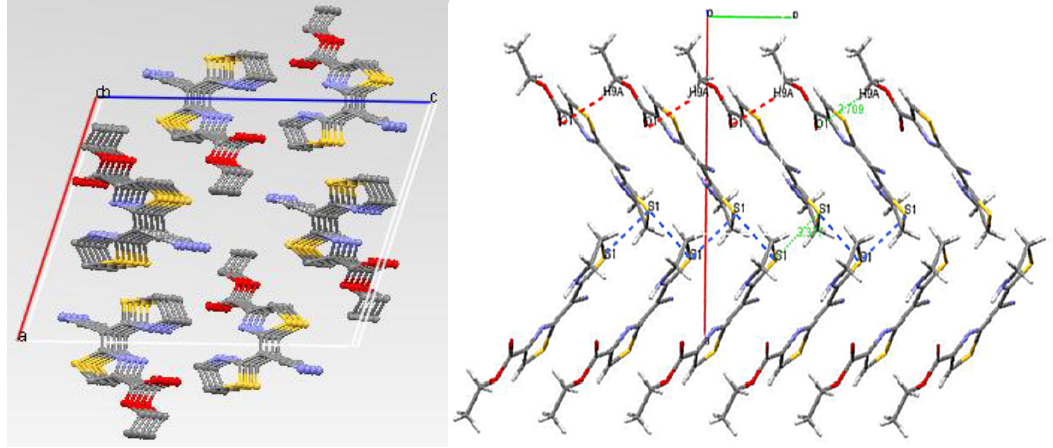
Figure 2. Molecular packing of 5a showing Van der Waals as dashed lines along b